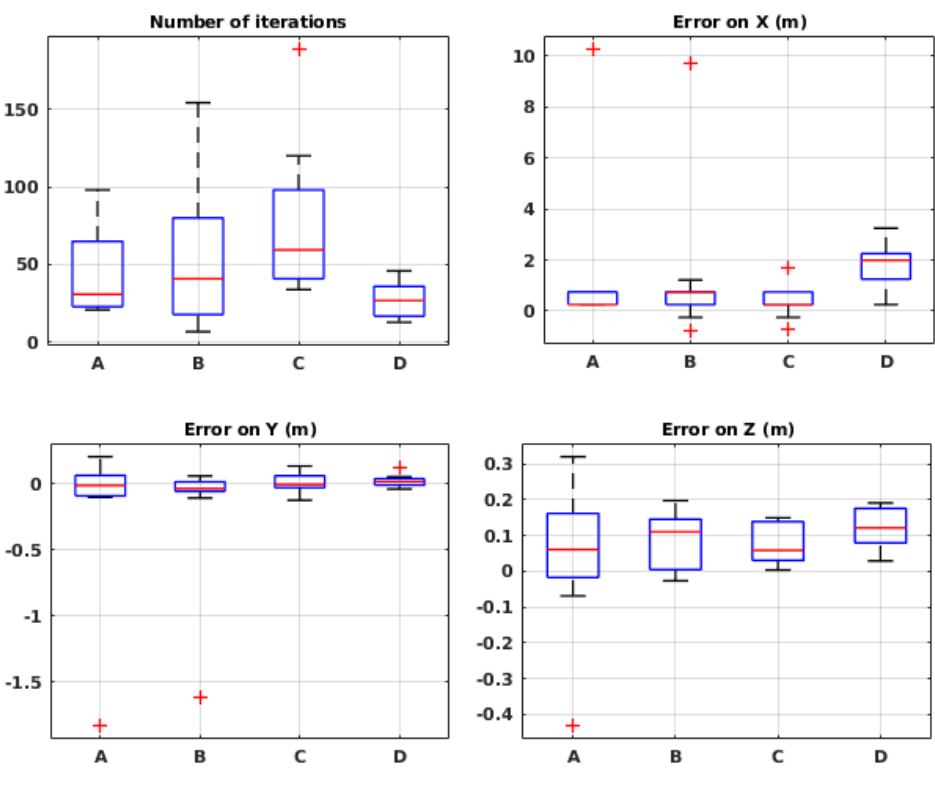
Figure 7. Evaluation results in simulation for different environmental conditions in the global